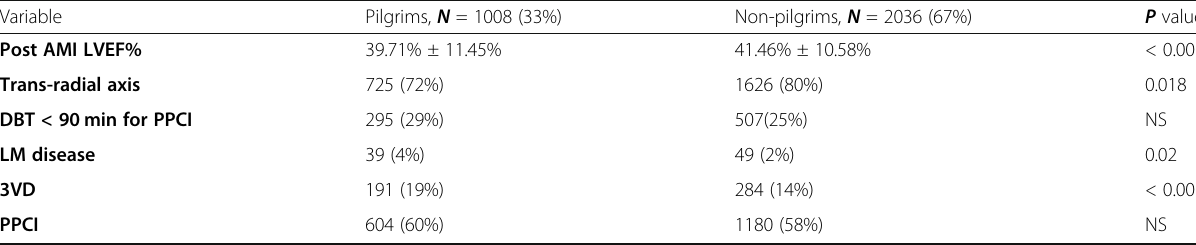
Table 2 Echocardiography and coronary angiography of pilgrim and non-pilgrim AMI patients Variable